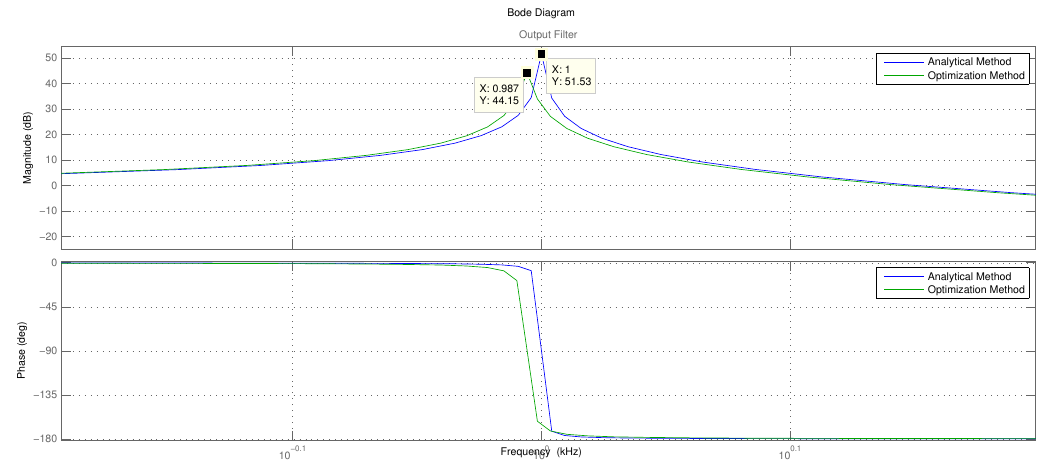
Figure 14. Graph of the magnitude and phase of the output